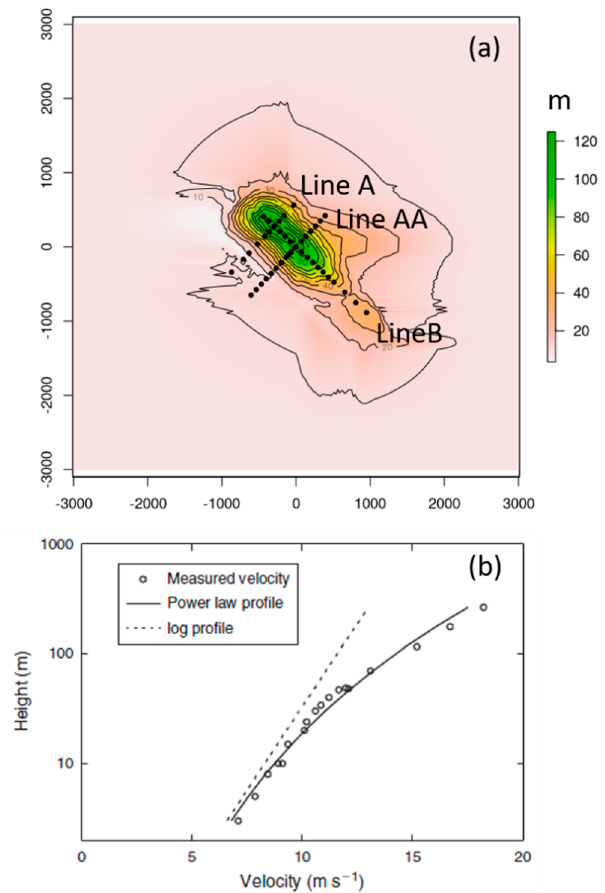
Figure 3. Askervein Hill ( a ) terrain and measurement locations with axes labeled in meters, with north toward the top of the figure and ( b ) the observed velocity profile measured at an upwind reference station compared to logarithmic and power law profiles; reproduced with permission from Forthofer et al. [1].